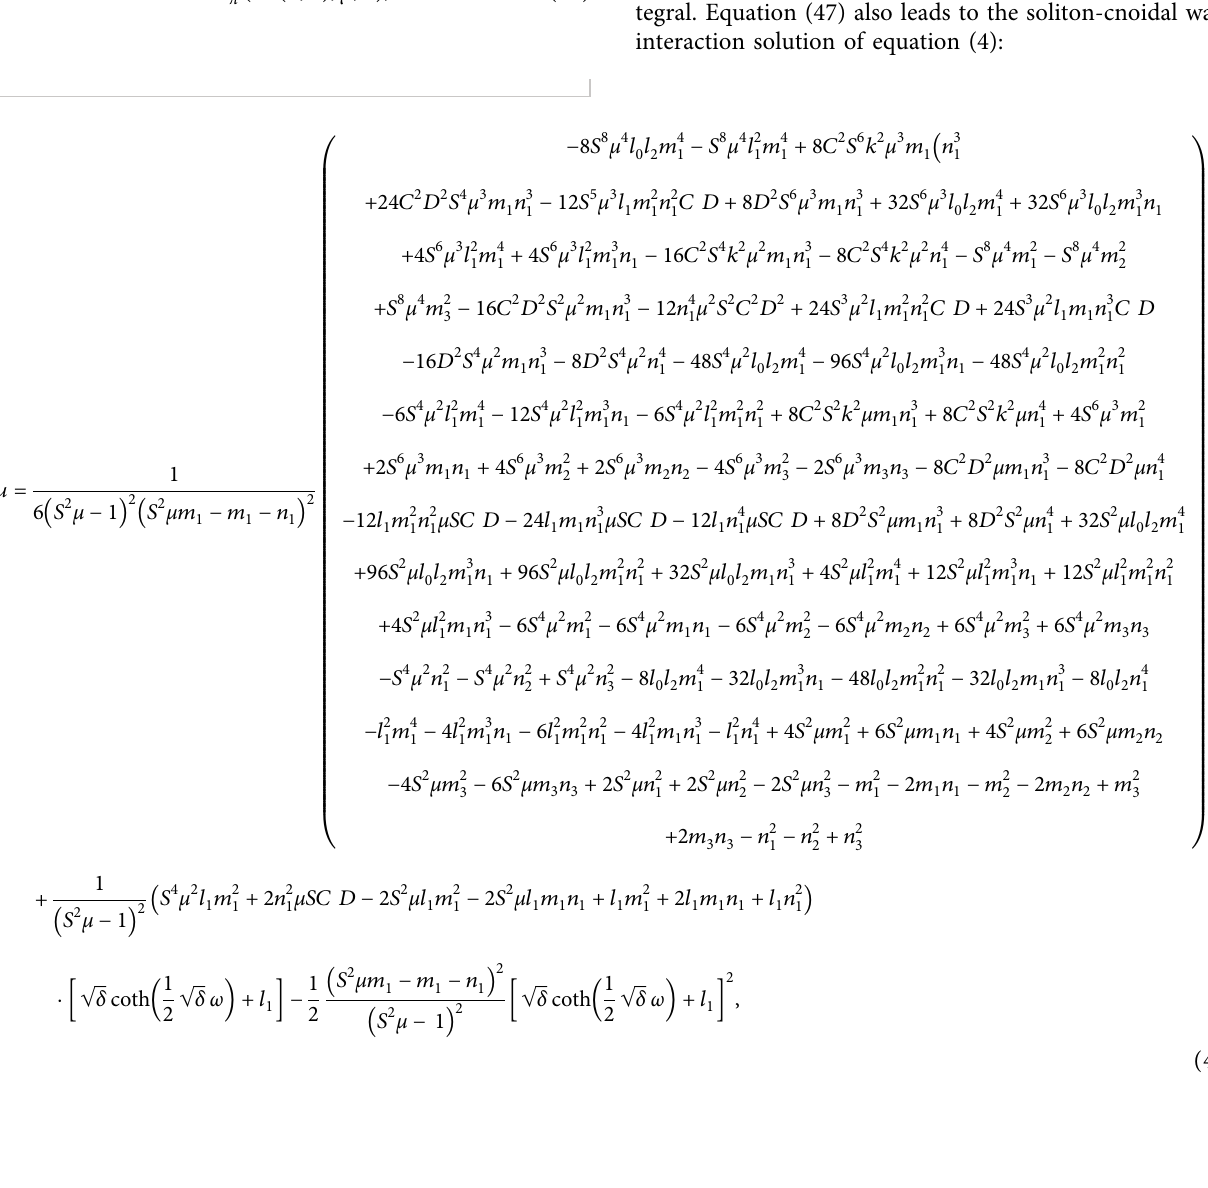
( η , μ , k ) denotes the third type of incomplete in- where E π tegral. Equation (47) also leads to the soliton-cnoidal wave interaction solution of equation (4):